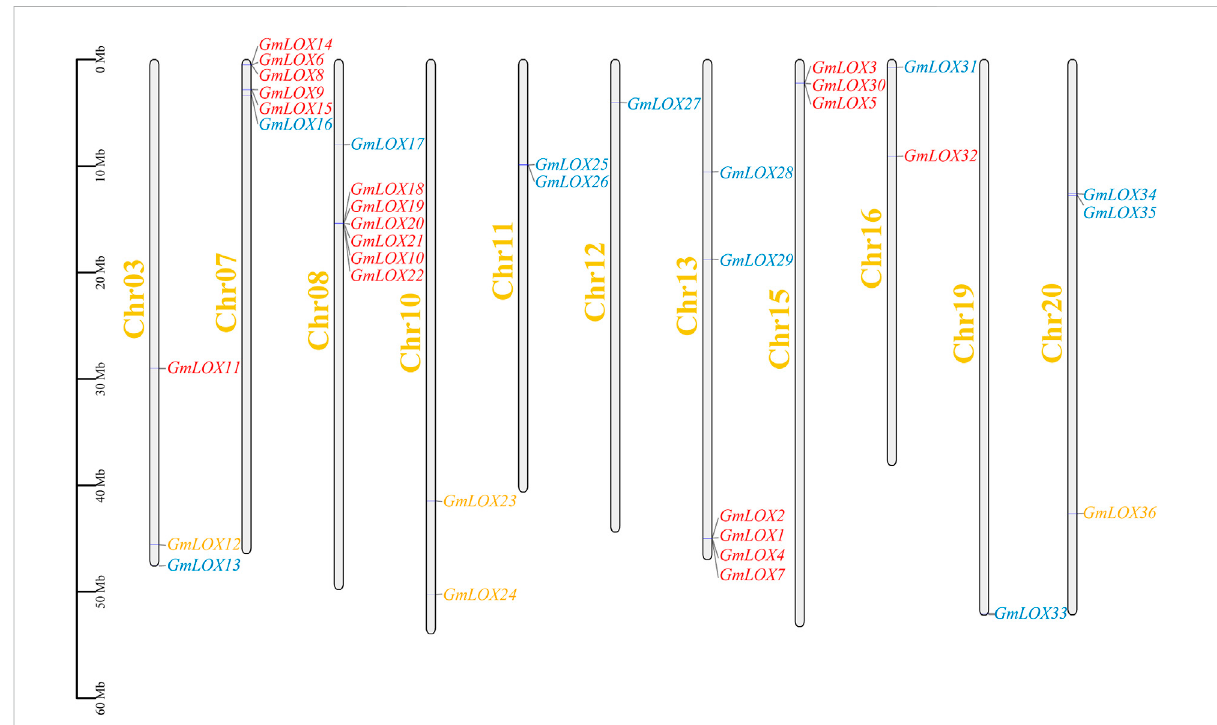
FIGURE 5 Chromosomal distribution of GmLOX family genes in Zhonghuang 13 Note: The scale is chromosome length (Mb). The grey bars represent chromosomes. Chromosome numbers are shown on the left side of the bar. Chr03-20, chromosomes in Zhonghuang 13. The GmLOX genes are marked on the right side of the